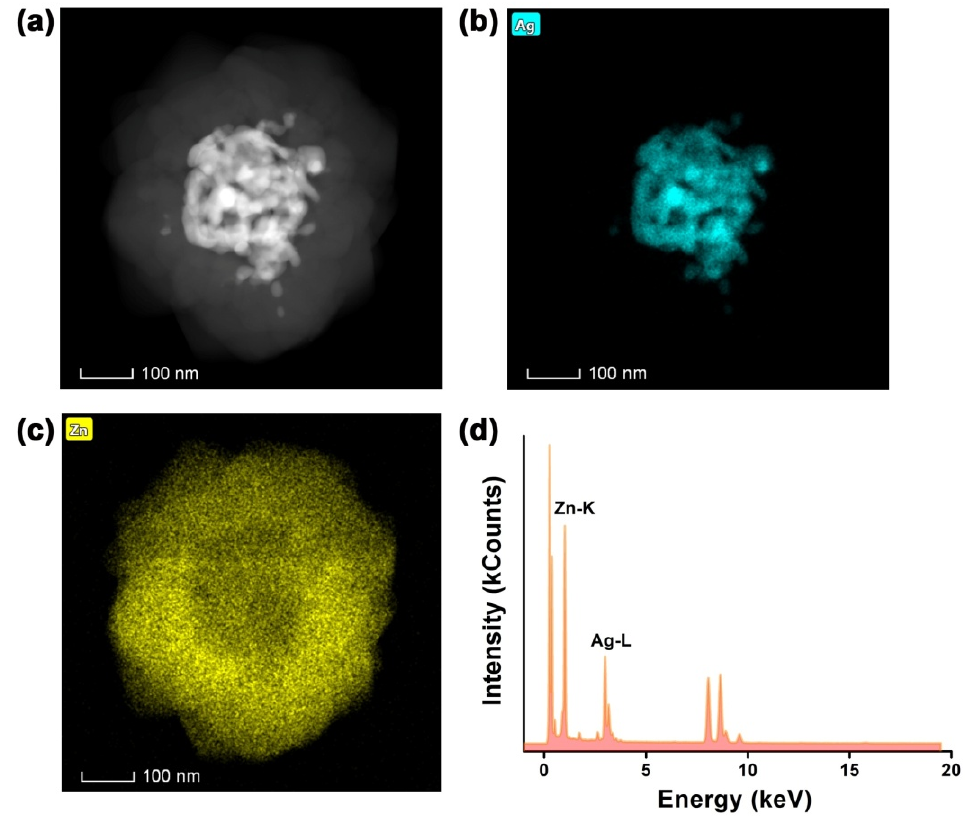
Figure 1. ( a ) HAADF-STEM image of NPS@ZIF and EDS mapping patterns of elements ( b ) Ag, ( c ) Zn. ( d ) Corresponding EDS elemental spectrum.